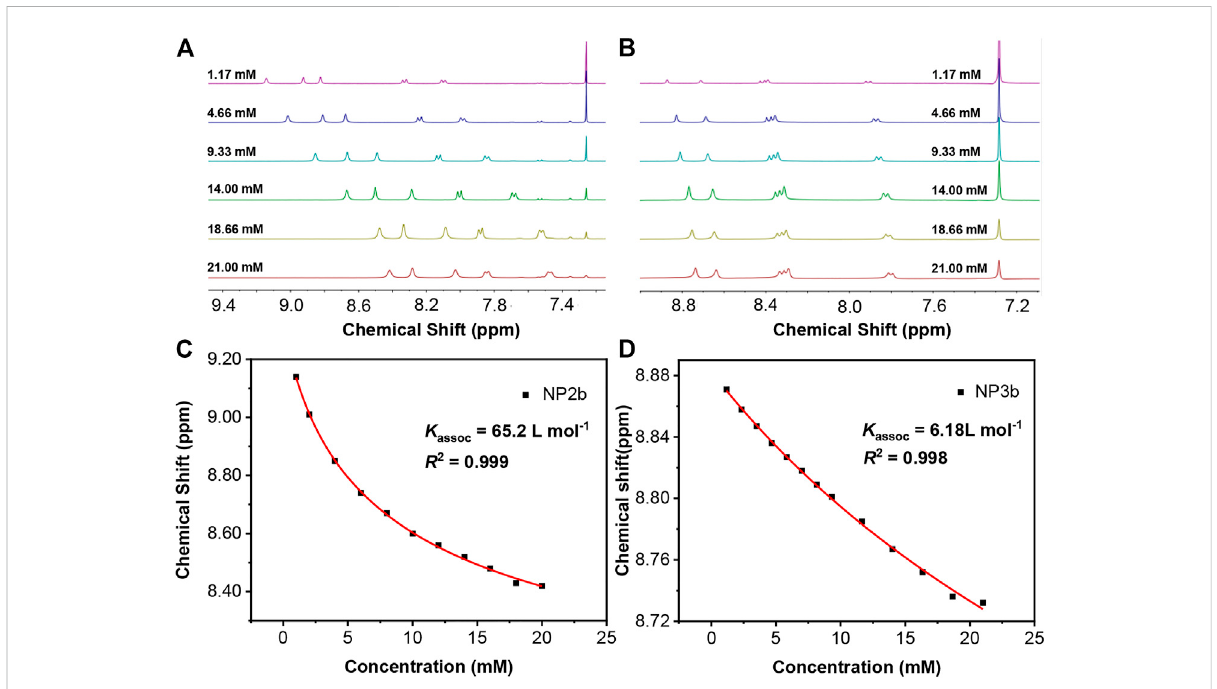
FIGURE 5 1 H NMR (in CDCl 3 ) spectroscopy at different concentrations for (A) NP2b (B) NP3b. Concentration-dependent images of chemical shifts fi tted by a monomer-dimer model and self-assembly constants of (C) NP2b, (D) NP3b. K assoc is the self-aggregating association constant and R 2 is the coef fi cient of